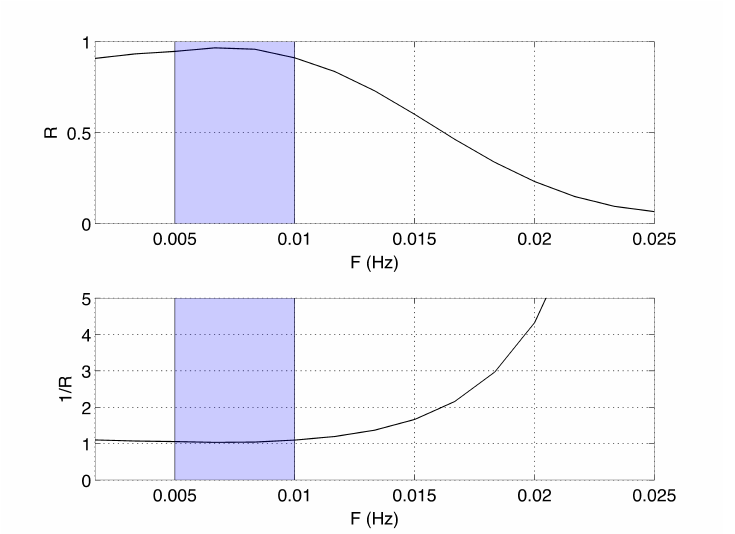
Figure A2. Upper panel : Amplitude response as a function of frequency for the low-pass FIR filter with the current IG-range indicated by the shaded area. Lower panel : The same for the inverse amplitude response used to retrieve the true IG spectra in the IG frequency range using Equation